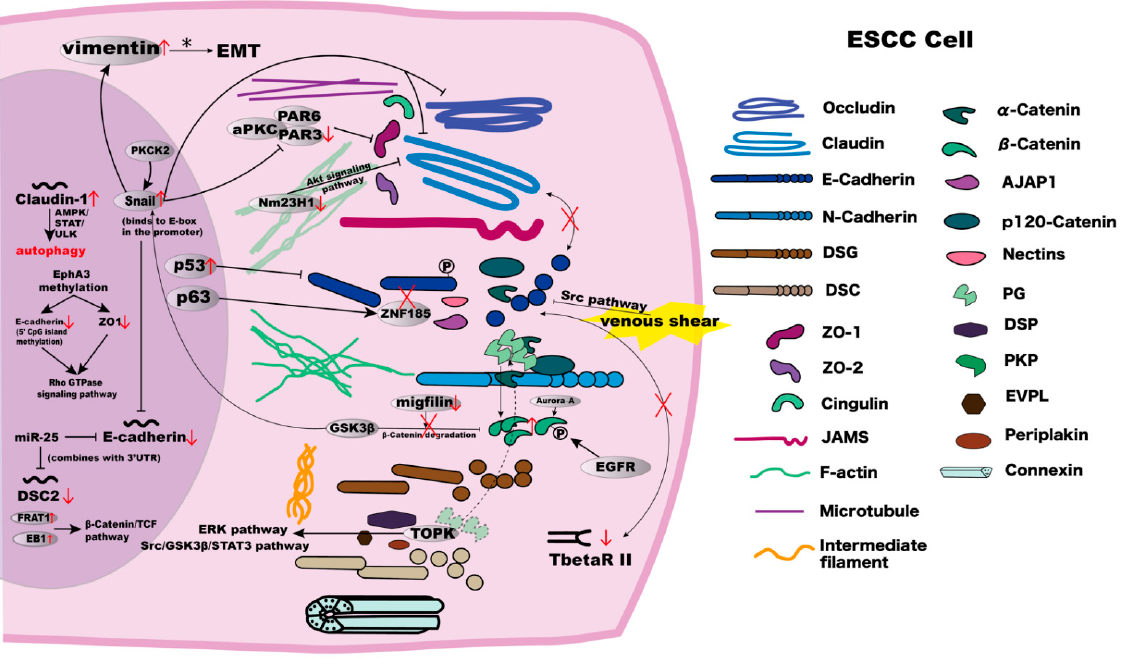
Figure 3. The mechanisms and interrelationships in components involved in cell–cell junctions in ESCC cells. Detailed explanations are summarised in Table 1.